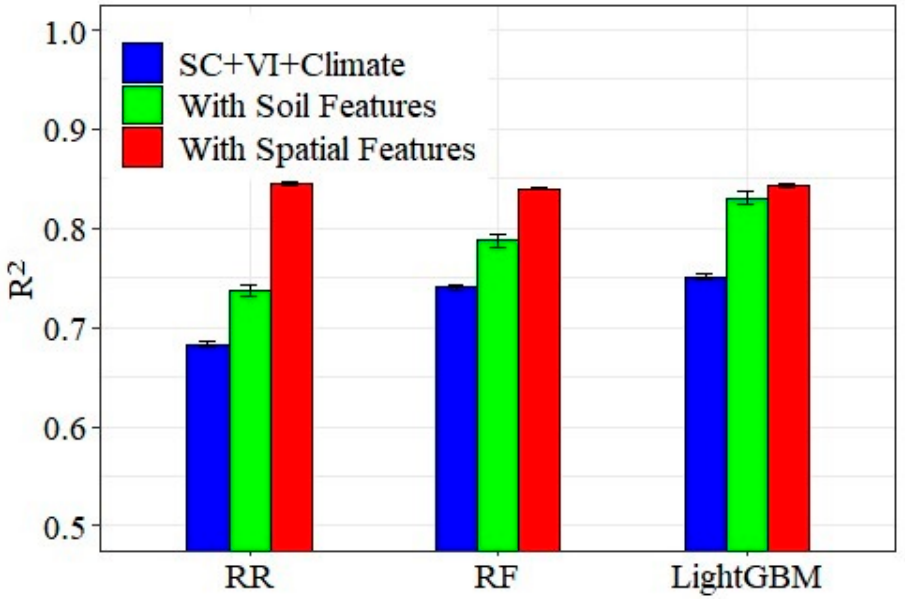
Figure 7. The model performance (predicted R 2 ) after including spatial information and soil properties; the green and red columns mean the R 2 after including the soil properties and spatial information in the benchmark model (blue color), respectively. The error bars are one standard deviation of predicted R 2 from 100 ensembles obtained by randomly dividing training and testing datasets.